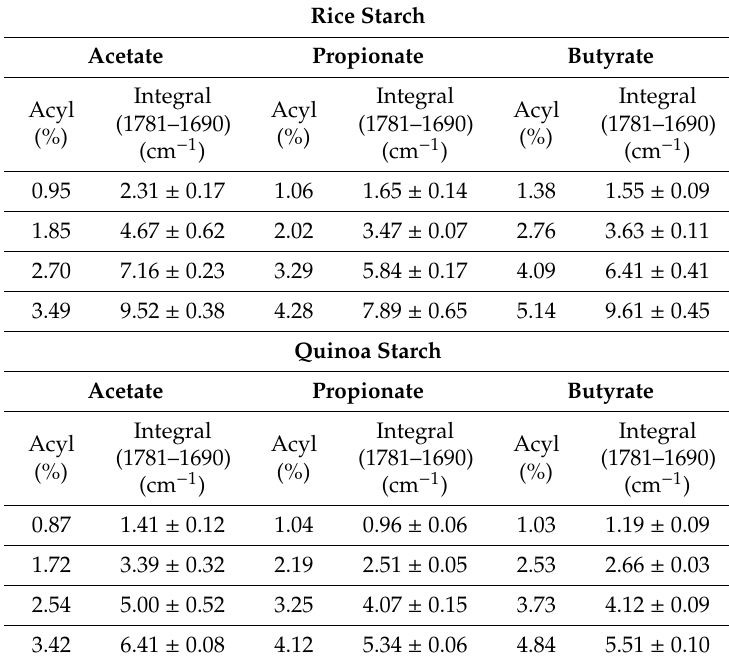
Table 5. Acyl content obtained from stoichiometric equation and integral of the carbonyl stretching vibration (C = O) band of rice and quinoa starch esters in the range of (1781–690 cm − 1